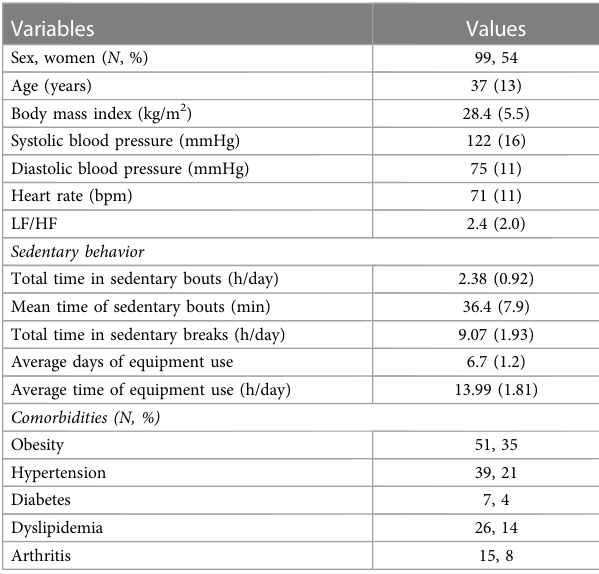
TABLE 1 General sample characteristics ( N